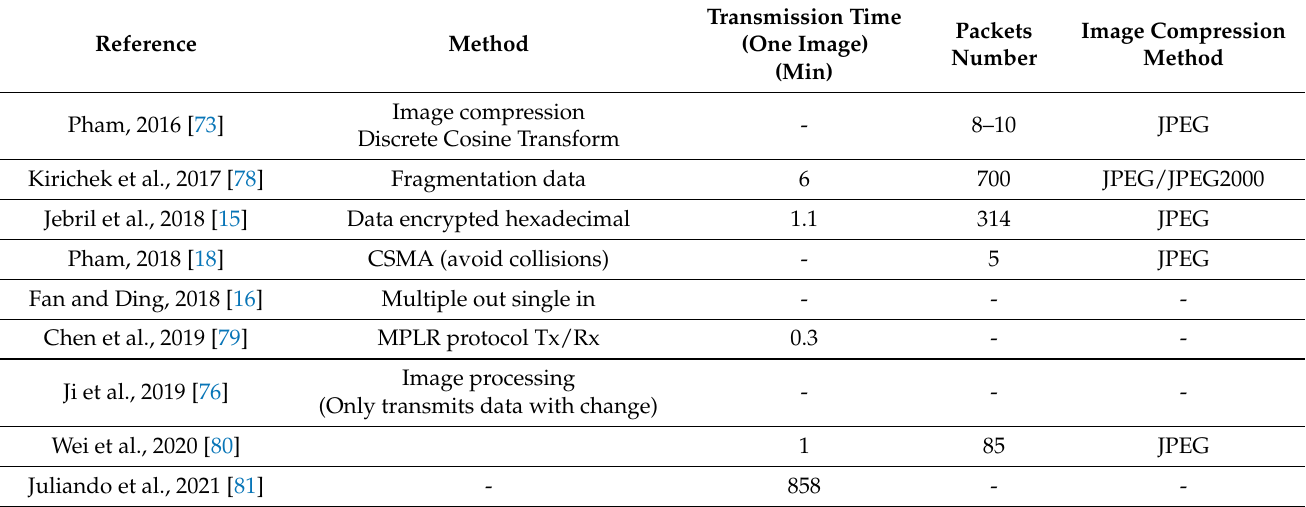
Table 1. Image transmission through LoRaWAN networks.